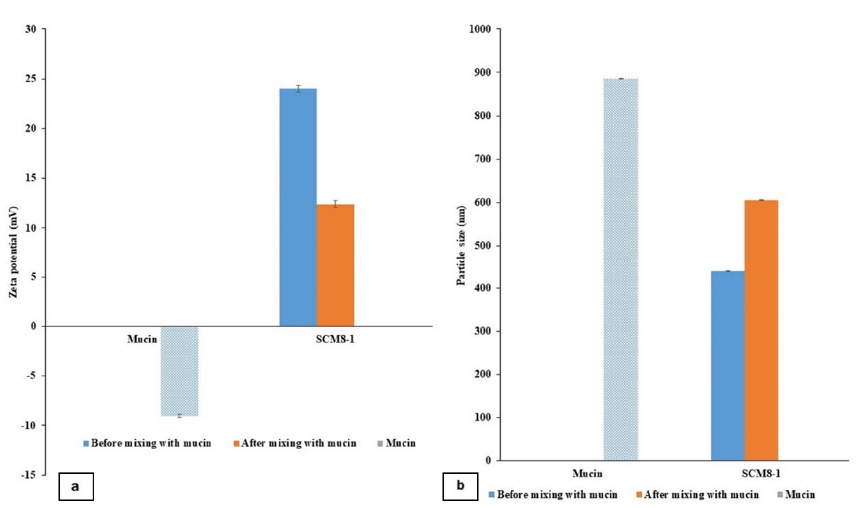
Figure 8. ( a ) Zeta potential and ( b ) particle size values of the selected formulation SCM8–1, before and after mixing with mucin